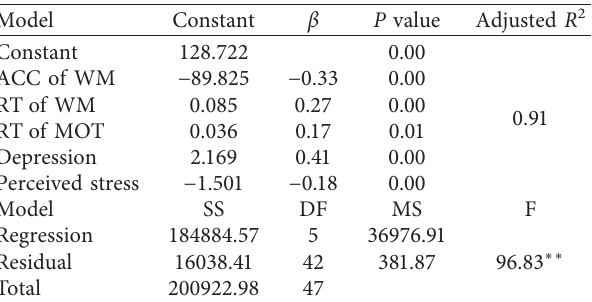
Table 5: Stepwise regression coefficients (beta weights) for the prediction of delay